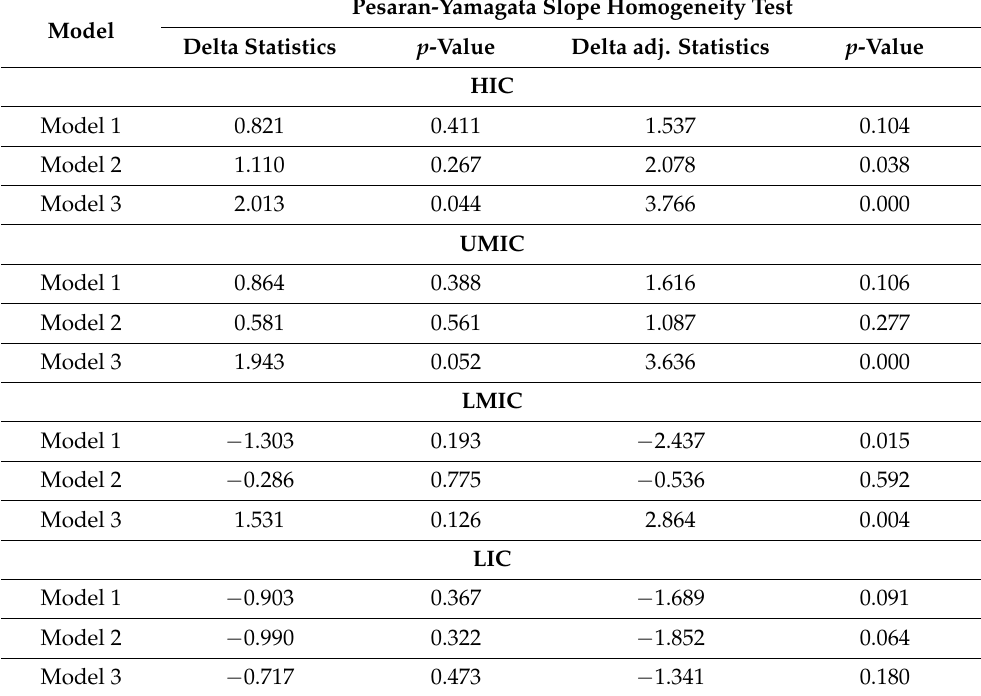
Table 3. Pesaran-Yamagata Slope Homogeneity